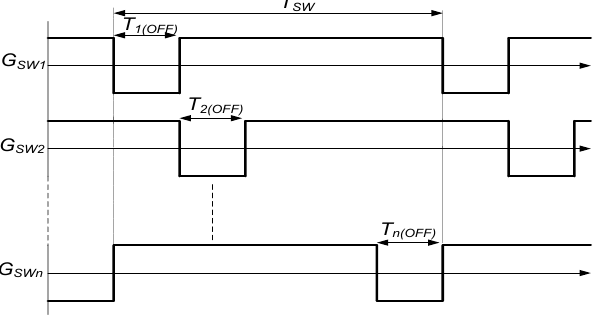
Fig 5 Gate signals of the multistage chopper for